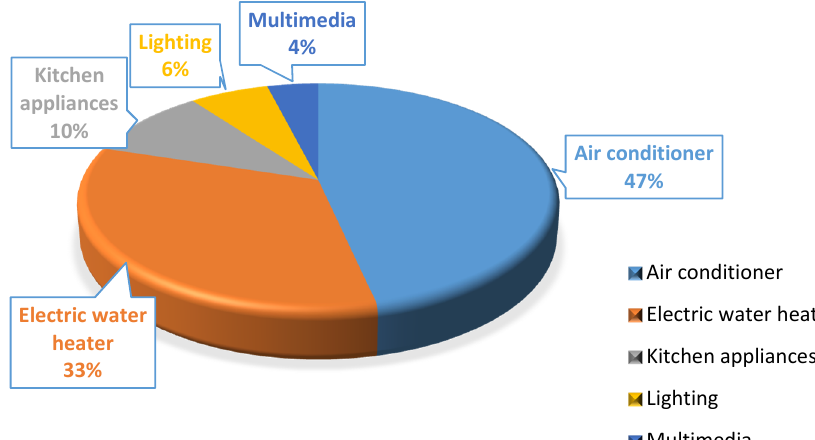
Figure 2. Residential electricity consumption in a week.